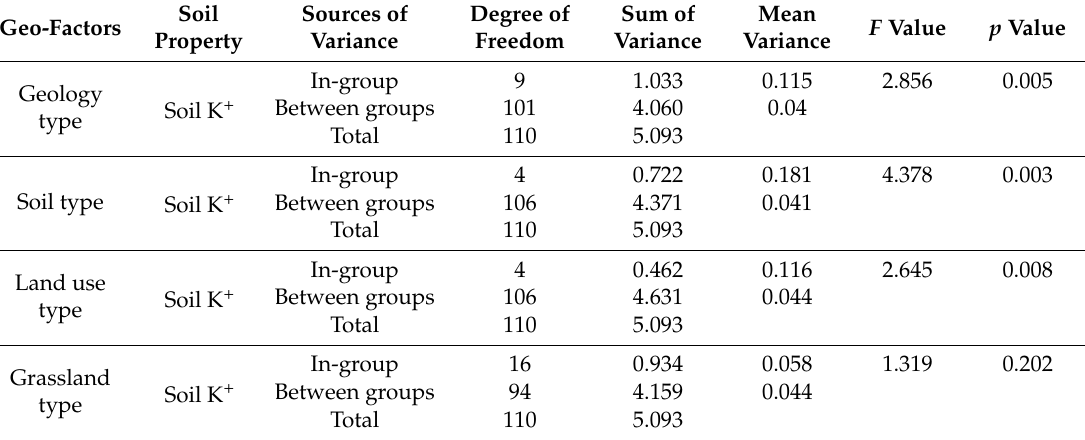
Table 3. ANOVA analysis for testing the significance of secondary variables on soil K +